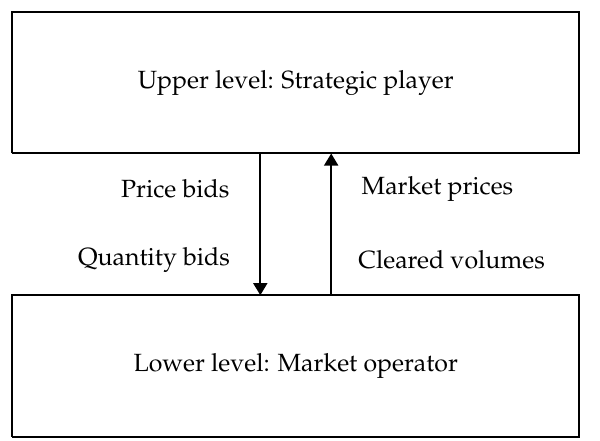
Figure 5. General structure of a bi-level model. The arrows represent the exchanges of decisions between the upper and the lower